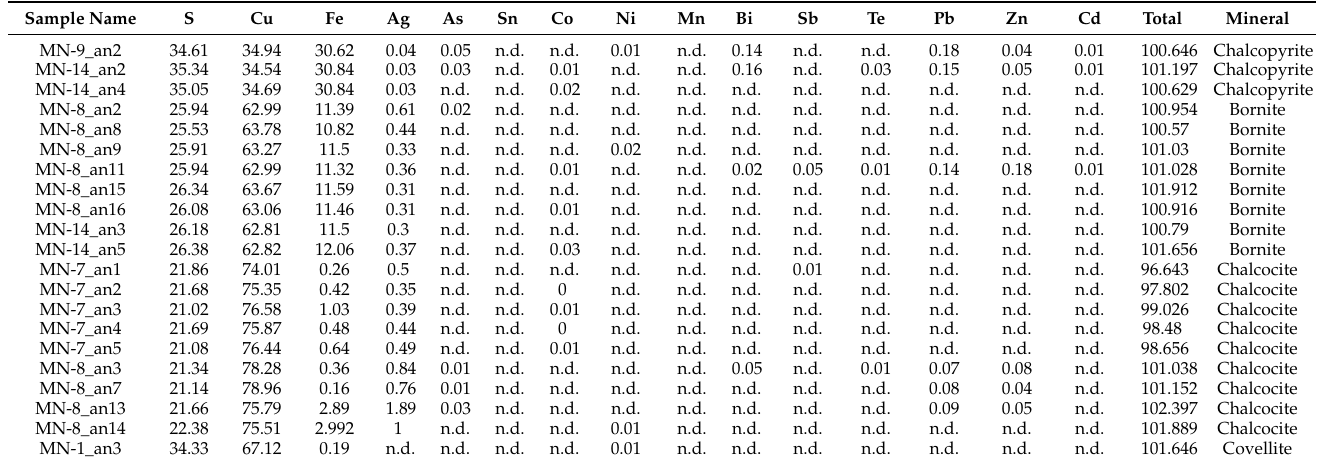
Table 2. Representative EPMA results (wt.%) of copper sulfides from the M ă n ă il ă ore deposit: chalcopyrite, bornite, chalcocite, and covellite.